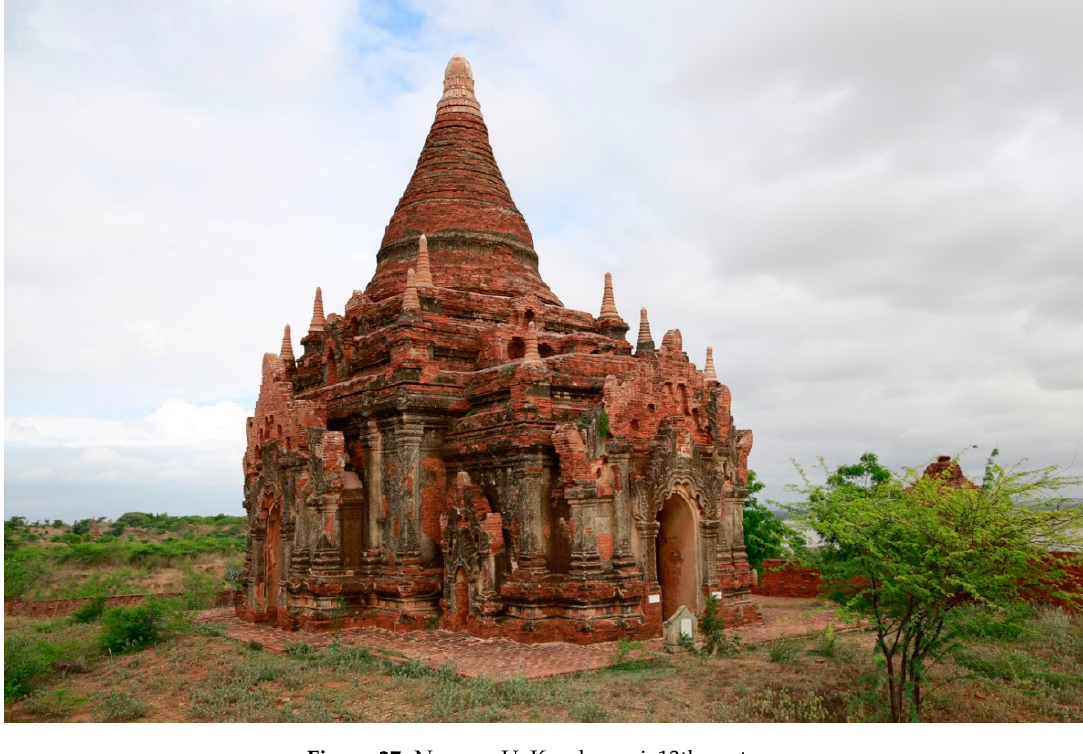
Figure 27. Nyaung U, Kondawgyi, 13th century.